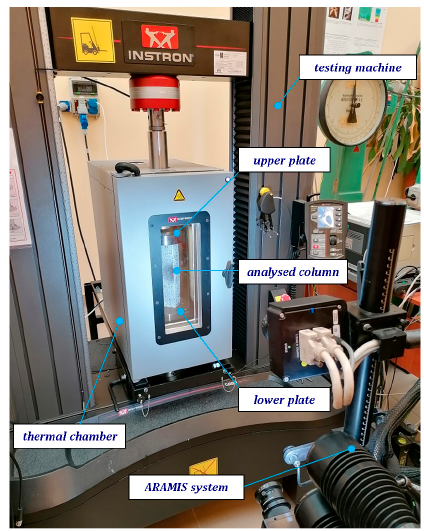
Figure 2. The testing stand equipped with the Aramis ® (digital image correlation) system.